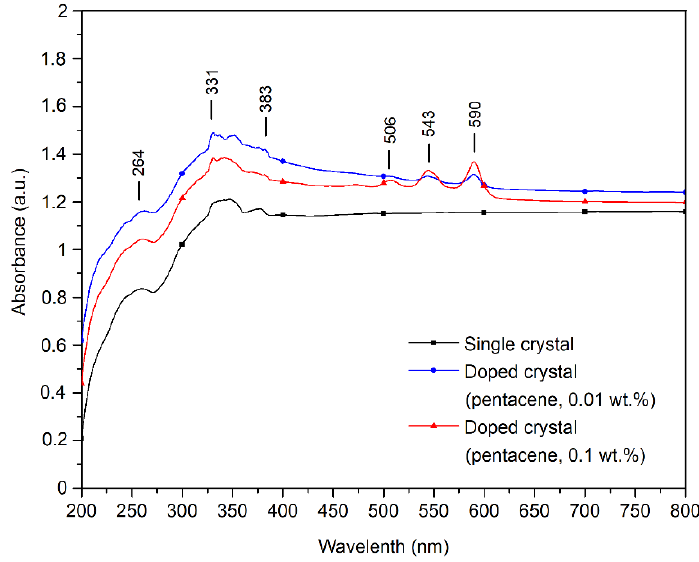
Figure 6. UV–visible absorption spectra of pure and pentacene-doped p-terphenyl crystals. Table 5. UV–Vis characteristic bands representing p-terphenyl in pure and pentacene-doped p- terphenyl crystals.